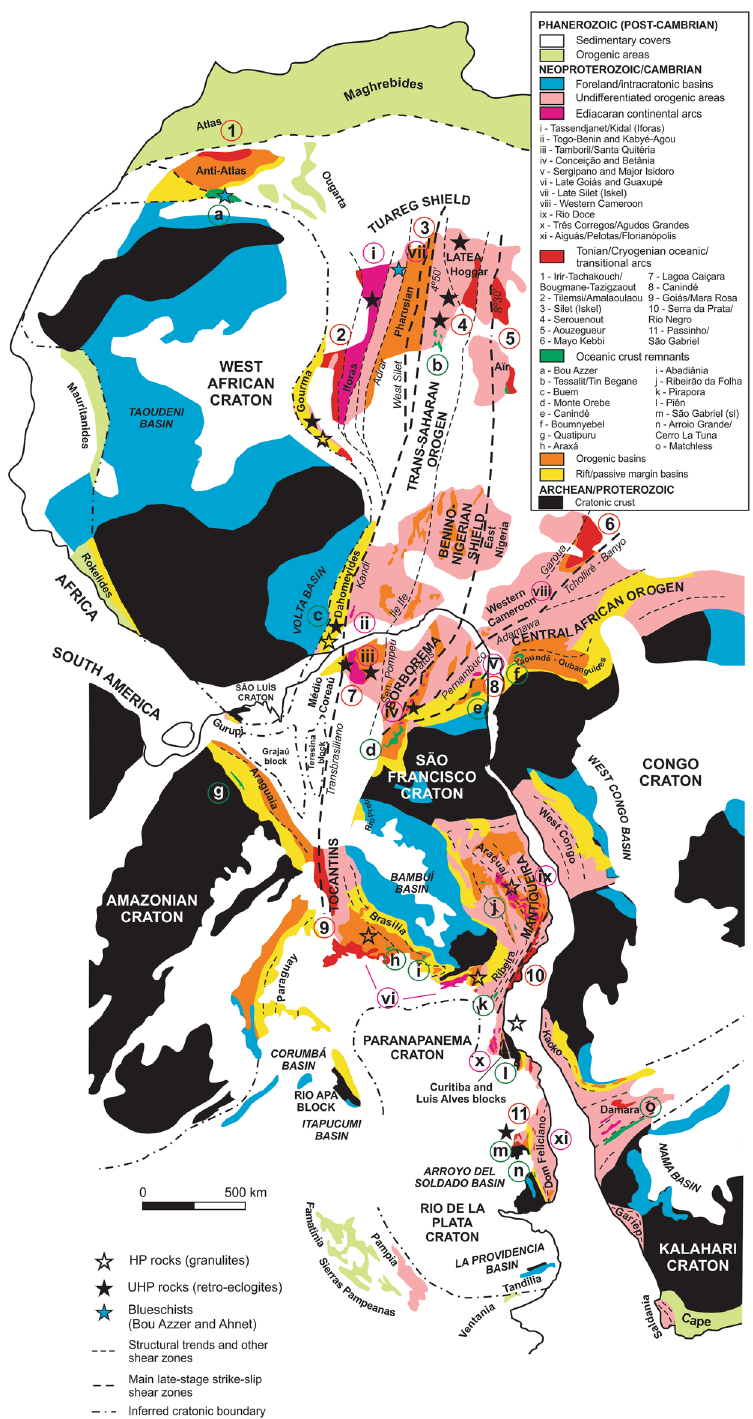
Figure 1. Simplified geology of eastern South America and western Africa in a pre-drift configuration. Dashed lines represent main shear zones. Map created using Corel Draw Graphics Suite 2018 (http:// www. corel draw. com) and a Huion Kamvas GS1331B pen display (http:// www. huion.